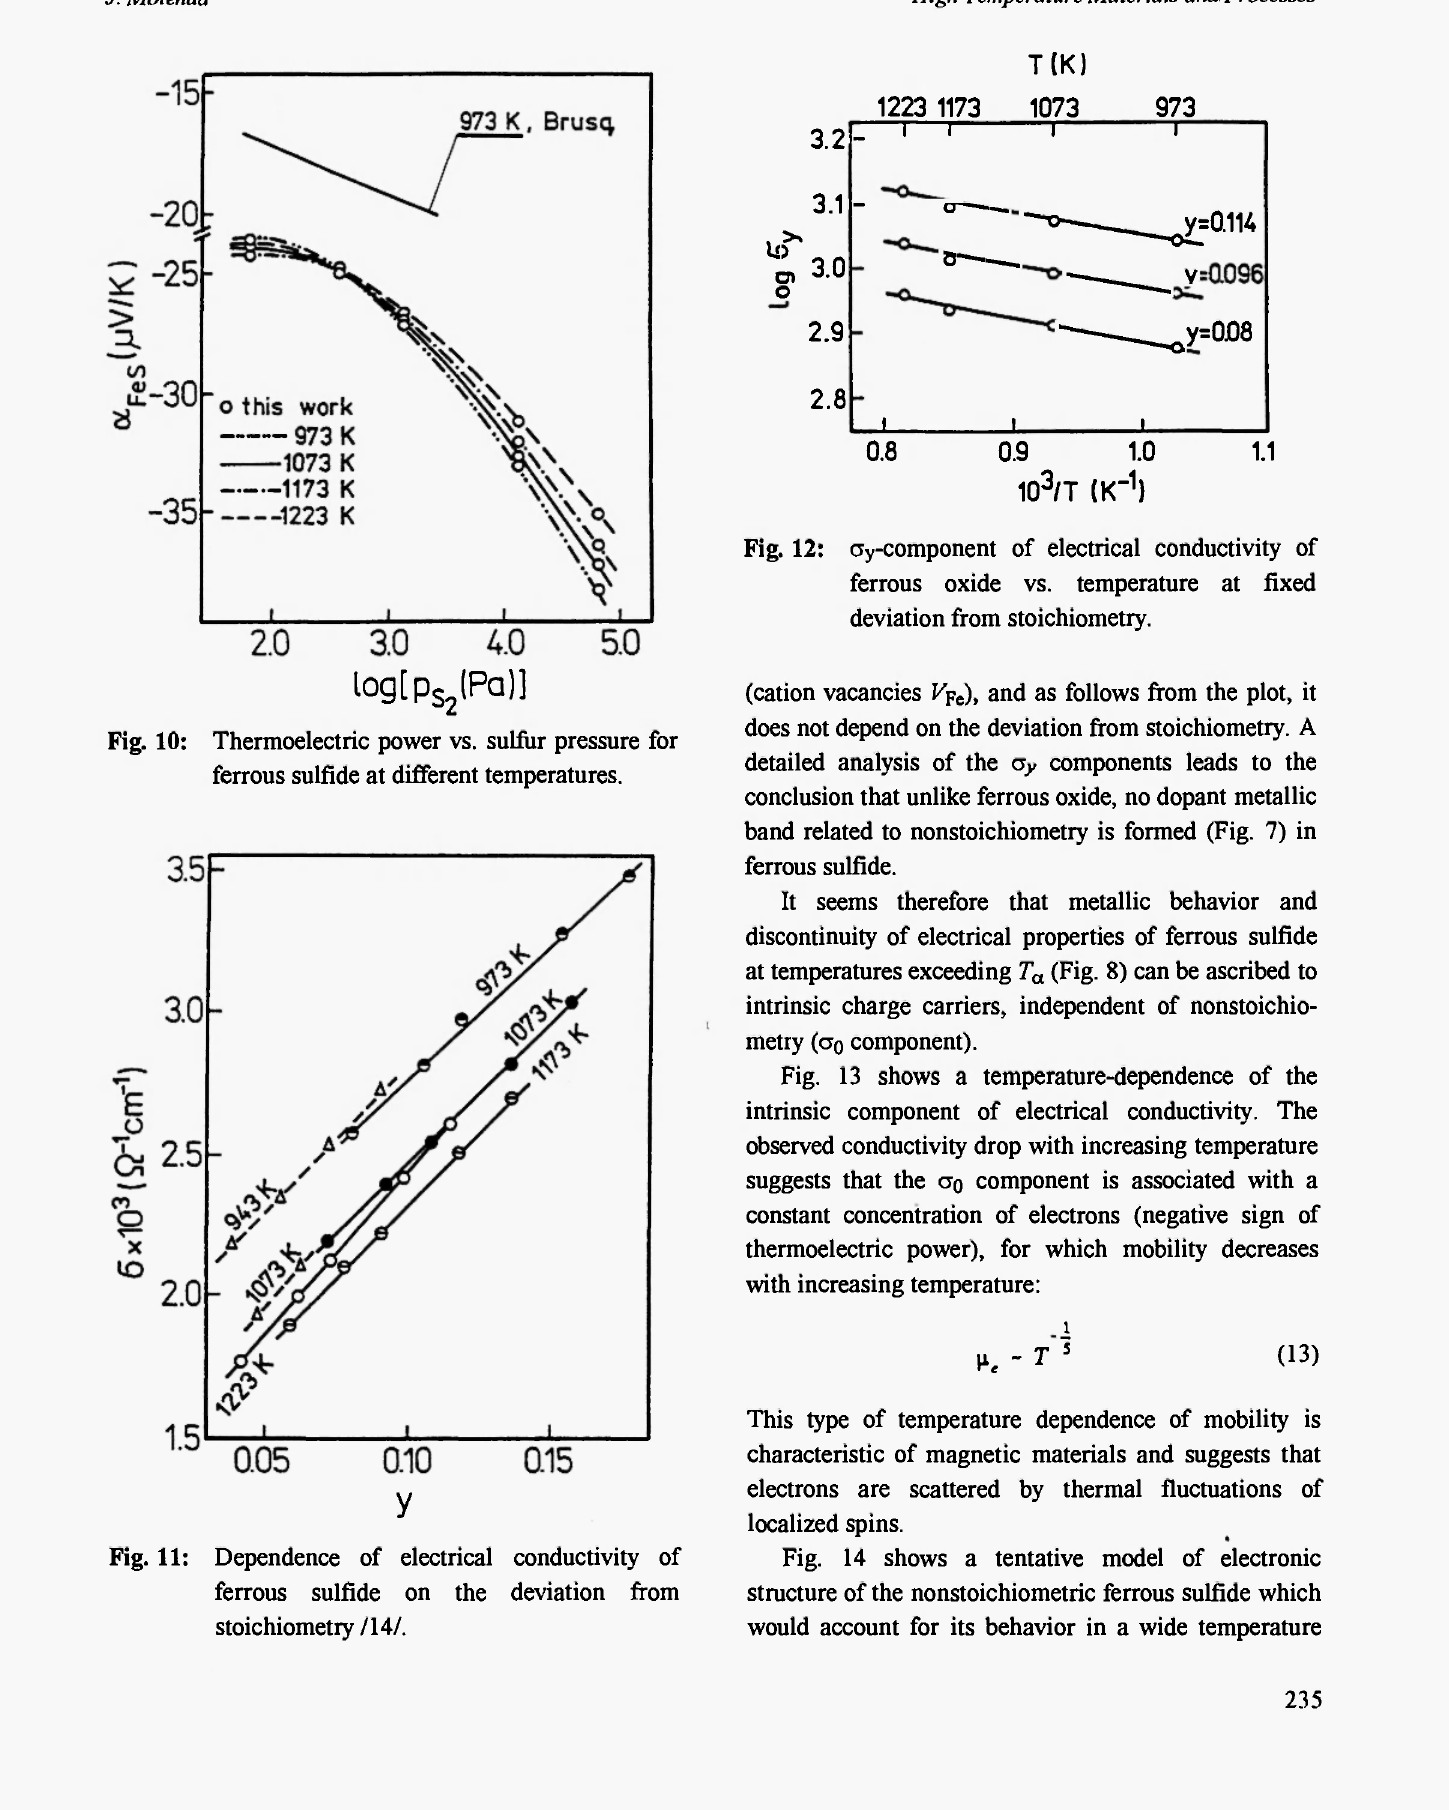
Fig. 12: ay-component of electrical conductivity of ferrous oxide vs. temperature at fixed deviation from